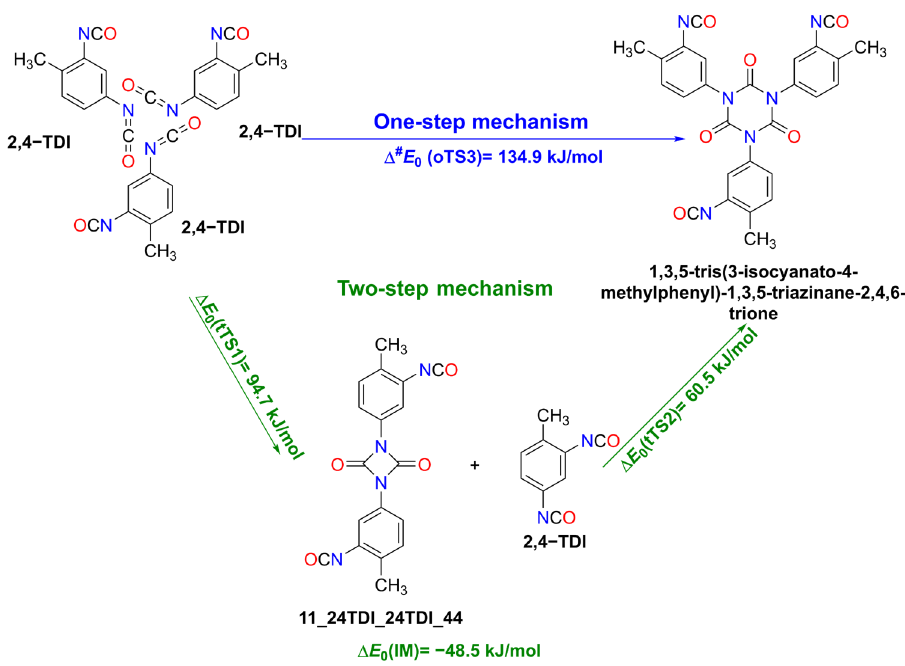
Figure 5. The one-step and two-step mechanisms resulting in a 2,4-TDI trimer. The qG3MP2B3 zero-point corrected relative energies are also presented.